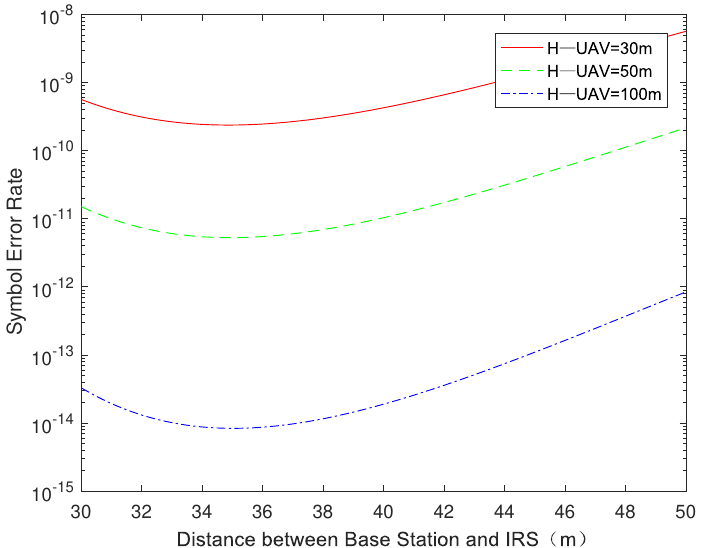
Figure 4. Symbol error rate versus d1 ; 30 m < d1 < 50 m, H UAV > 22.5